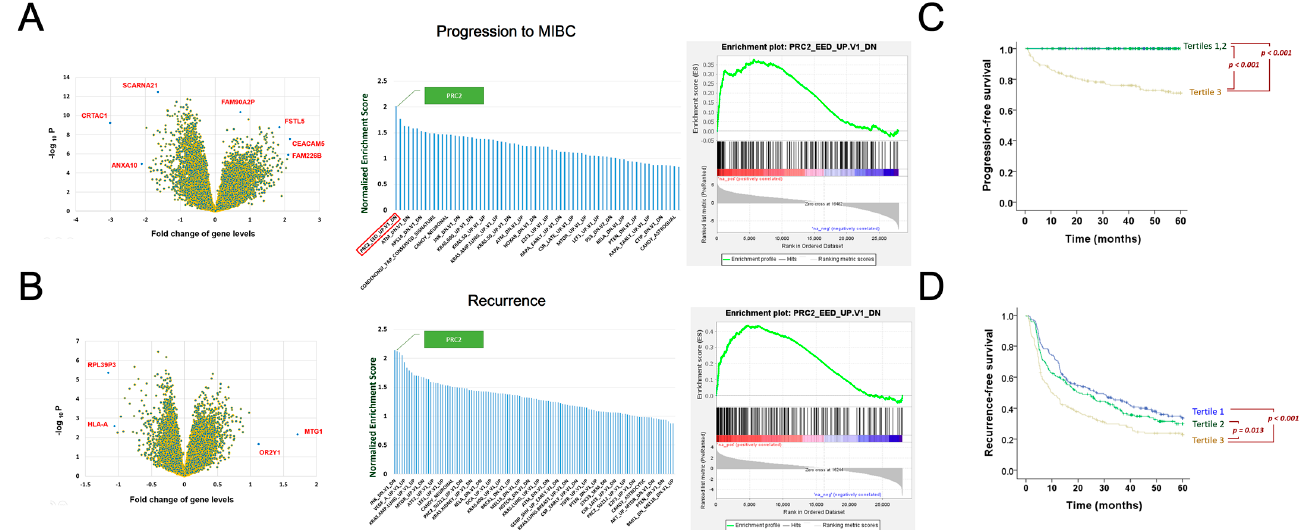
Figure 1. Discovery of PRC2 and downstream machinery, which drives the progression and recur- rence of NMIBC after curative surgery. ( A ) The GSEA analysis of leading oncogenic mechanisms pertaining to the progression to MIBC, using transcriptome in patients with and without progression. The differential transcriptome is shown as a scatter plot of fold change and negative logarithm of significance (i.e., a volcano plot) in the left. Among a collection of 120 oncogenic mechanisms evaluated, the PRC2-related oncogenic mechanism is identified as the top driving mechanism with the highest normalized enrichment score (NES = 2.01). The standard GSEA enrichment plot of the PRC2-related oncogenic mechanism is shown in the right. ( B ) The GSEA analysis of leading oncogenic mechanisms pertaining to NMIBC recurrence, based on the differential transcriptome in patients with and without recurrence, which is shown as a volcano plot in the left. JNK and PRC2 are the top two major mechanisms involved, with a normalized enrichment score >2. One in four consecutive gene sets were shown in the x-axis label due to space limitation. ( C ) The Kaplan–Meier plot of time to progression (to MIBC) in patient strata by the risk model shown in Equation (1). Blue: tertile 1. Green: tertile 2. Brown: tertile 3 (overall log-rank p < 0.001). ( D ) The Kaplan–Meier plot of time to recurrence in patient strata by the risk model (overall log-rank p =